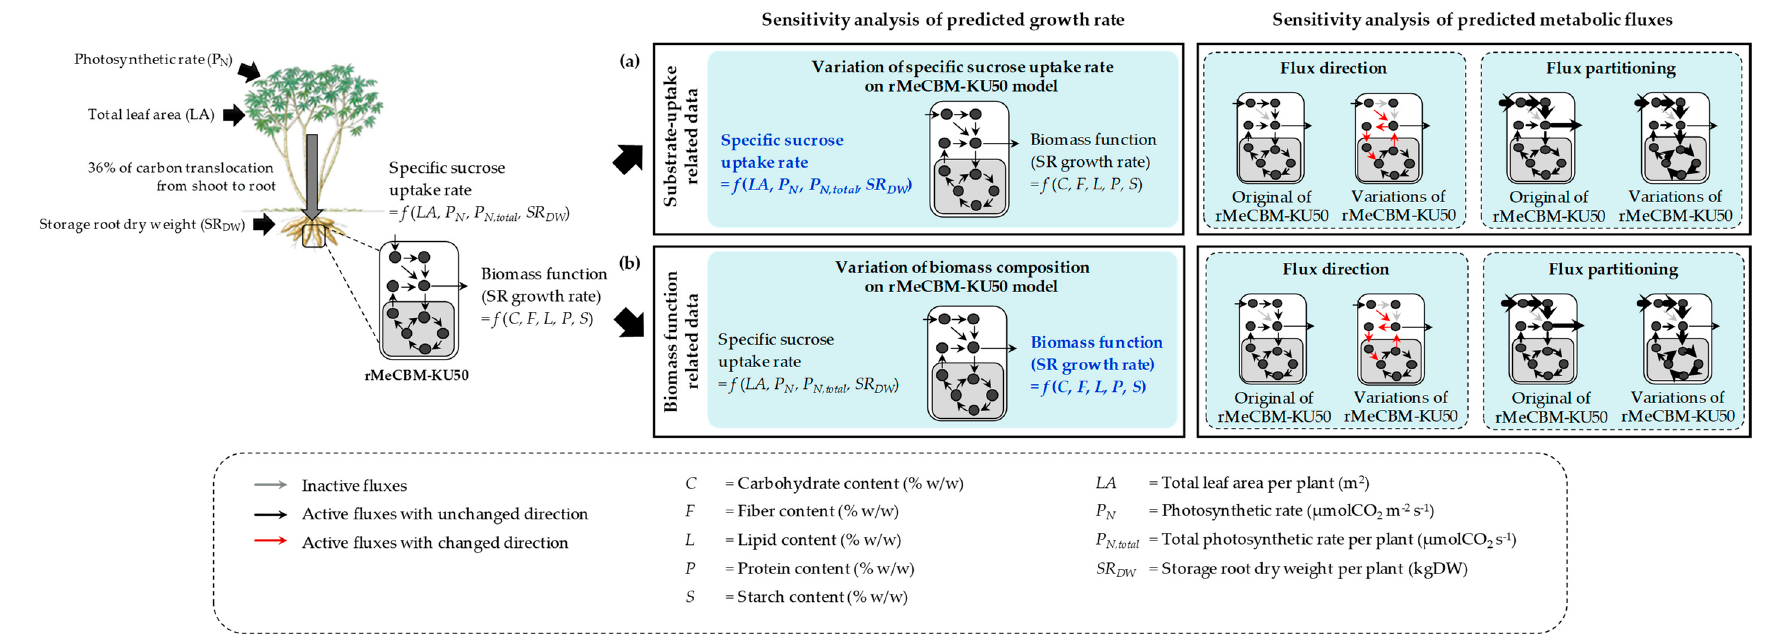
Figure 1. Overall framework of rMeCBM-KU50 model assessment to changes of ( a ) substrate–uptake related data (i.e., the specific sucrose uptake rate, photosynthetic rate, total leaf area, storage root dry weight, and total photosynthetic rate) and ( b ) the biomass function-related data (i.e., composition of biomass components). Each data variation, the sensitivity analysis of model prediction examined the changes in the predicted growth rate, as well as the changes of metabolic flux direction and partitioning. Inactive fluxes refer to zero-flux reactions (gray arrows). Active fluxes refer to non-zero flux reactions (black arrows—with unchanged direction; and red arrows—with changed direction). The thickness of the arrows indicates the flux magnitude.